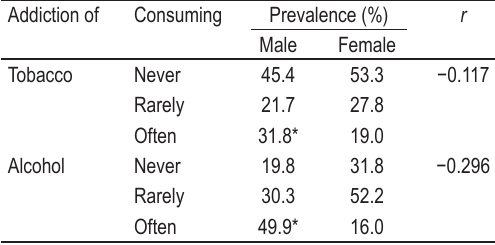
TABLE 3. Family factors related to adolescents tobacco and